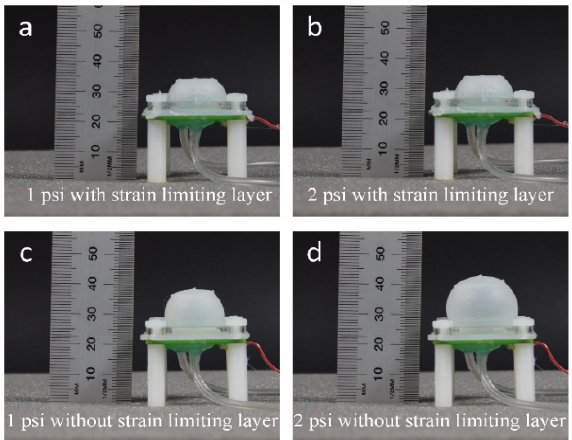
Figure 3. Comparison between structural expansions of the inflatable domes designed for the proposed sensor. The dome with a strain-limiting layer exhibited no deformation when it was pressurized with air to ( a ) 1 psi and ( b ) 2 psi. The prototyped domes without strain-limiting layer showed obvious deformation when pressurized with air to ( c ) 1 psi and ( d ) 2 psi.